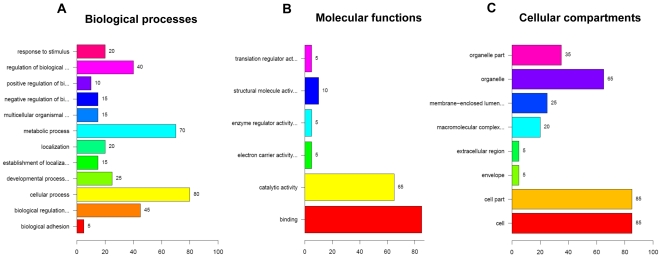
Functional classification of differential expressed proteins in different tumor groups.(A) The biological processes, (B) molecular functions and (C) cellular compartments regulated by the differentially expressed proteins between both tumor groups assessed by Gene Ontology search.